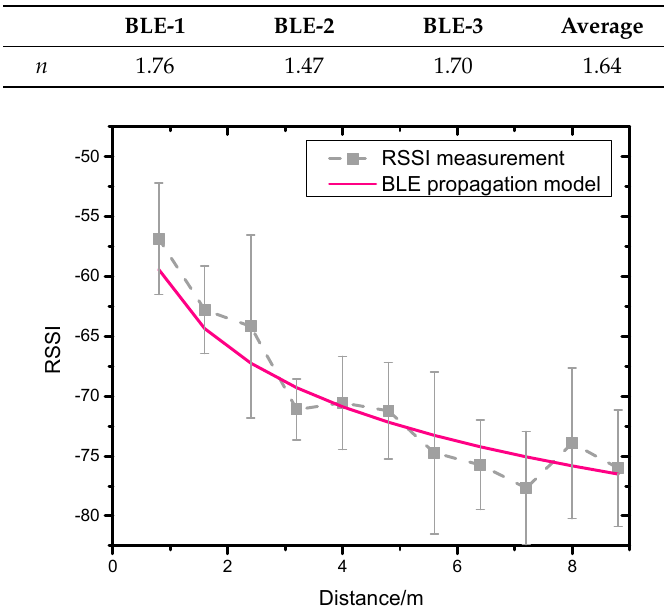
Table 2. Calculations of the loss path exponent n .